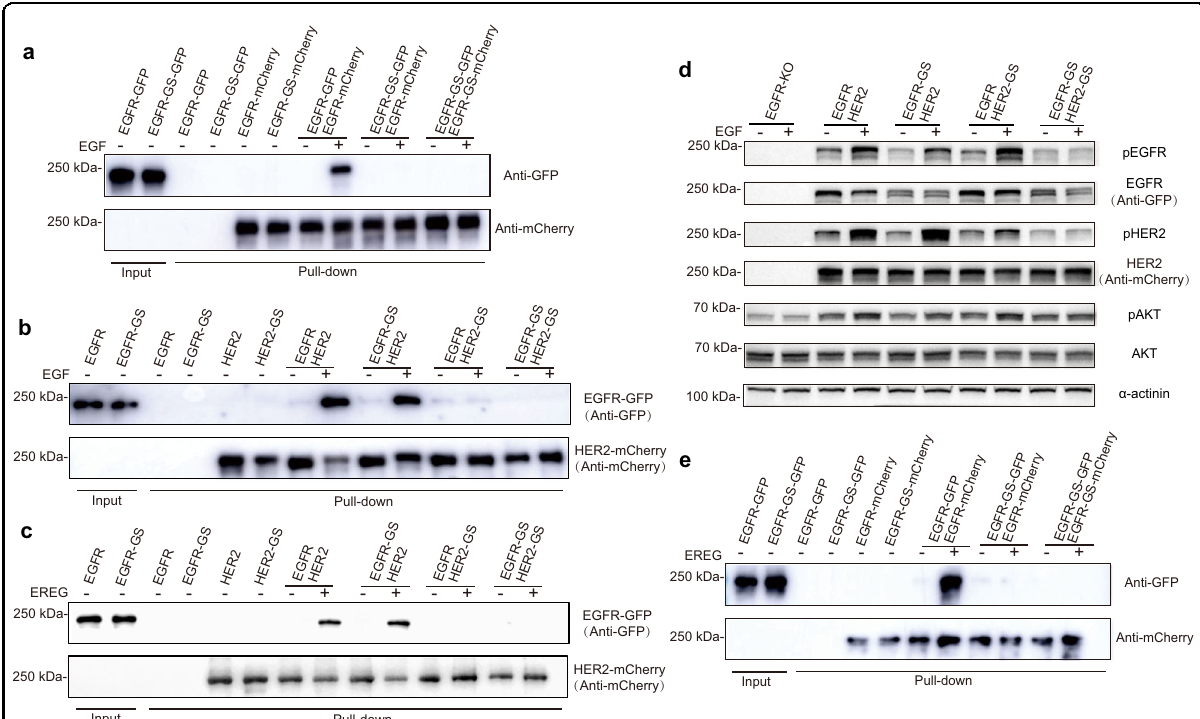
Fig. 4 Functional signi fi cance of the DA of EGFR or HER2 for their dimer assembly. a Pull-down assay to verify the signi fi cance of DAs for EGF- induced EGFR dimerization. The mCherry-tagged EGFR was associated with the mCherry-nanobody (Nb) resin, and GFP-tagged EGFR was used as input for this assay. b , c Pull-down assay to verify the signi fi cance of DAs for EGF- ( b ) or EREG-induced ( c ) EGFR/HER2 interaction. The mCherry-tagged HER2 was associated with the mCherry-Nb resin, and GFP-tagged EGFR was used as input for this assay. d Detection of the phosphorylation levels of EGFR, HER2, and AKT upon EGF stimulation. Different EGFR and HER2 variants were transfected to the EGFR-knockout SUM159 cells. e Pull-down assay to verify the signi fi cance of DAs for EREG-induced EGFR